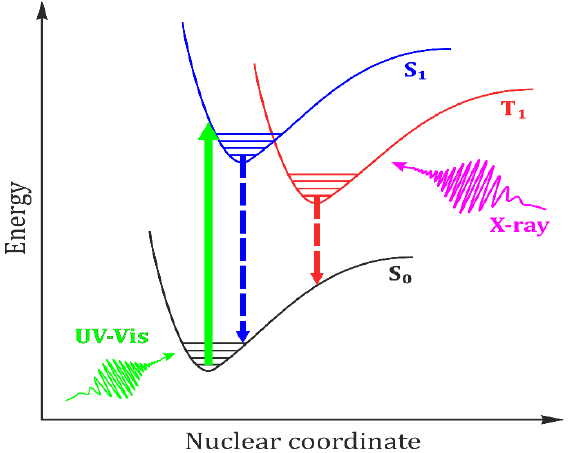
Figure 1. Schematic representation of the laser-pump/X-ray-probe experiments. The ground state of the system is excited with a laser-light pulse (large green arrow) to some higher-energy state with different geometrical features. Before the excited state relaxes back (dashed lines) to the ground state it is probed with the intense X-ray pulse. In this simple example ground state is indicated as singlet (S 0 ), and possible excited states are shown as higher energy singlet (S 1 ) and lower energy triplet (T 1 ), the latter exhibiting larger molecular deformation and a rather long lifetime.